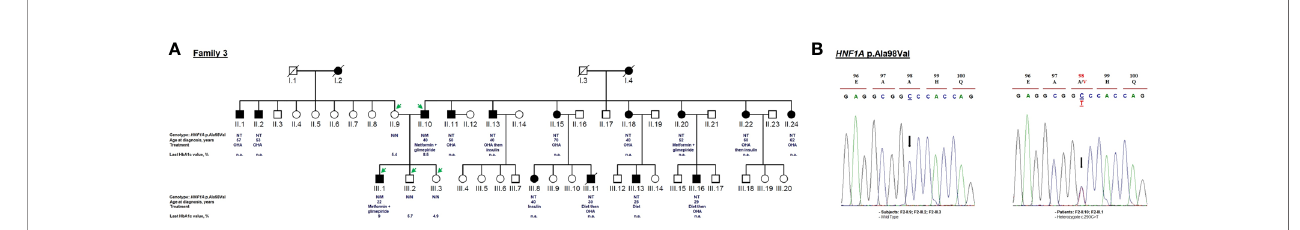
FIGURE 4 | Mutation analysis of the HNF1A gene. Panel (A) Pedigree of the family F3 identi fi ed with HNF1A variant (NM_000545.8: c.293C>T, p.Ala98Val). OHA, oral hypoglycemic agents; NT, not tested; n.a, Not available. M and N denote mutant and wild-type alleles, respectively. The age of diabetes onset, treatment follow- up, and last HbA1c measurement are indicated directly below the genotype (were available). Panel (B) Electropherograms showing co-segregation of the heterozygous variant c.293C>T in HNF1A gene to the phenotype observed in the proband and his father. Proband III.1 and his father II.10 carry heterozygous alleles (C/T) linked to the phenotype whereas non-affected subjects (mother II.9 and siblings III.2, III.3) carry homozygous alleles (C/C). Mutated nucleotide on the chromatographs is depicted with an arrow. Amino acid substitution is indicated